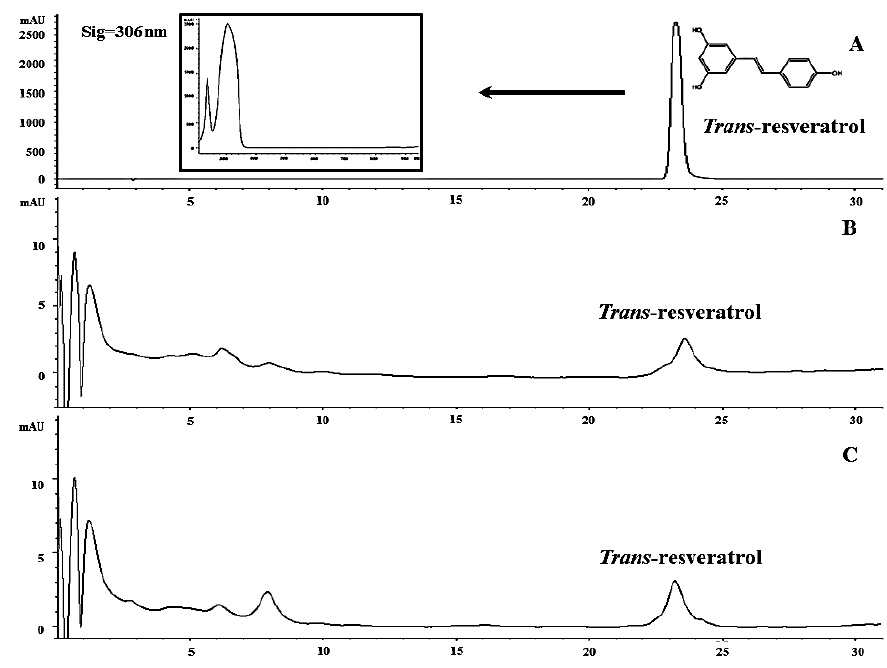
Figure 3. Chromatogram profile at 306 nm of ( A ) external standard trans -resveratrol with UV-Vis spectra, ( B ) 0 mg/L (control), and ( C ) 500 mg/L of Vitis vinifera cell treated with ammonium nitrate for 14